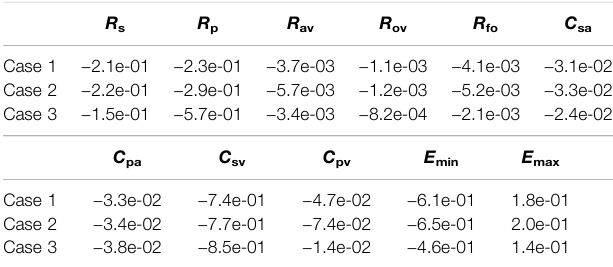
TABLE 6 | Sensitivities for cases 1, 2, and 3 computed for the effective oxygen availability.